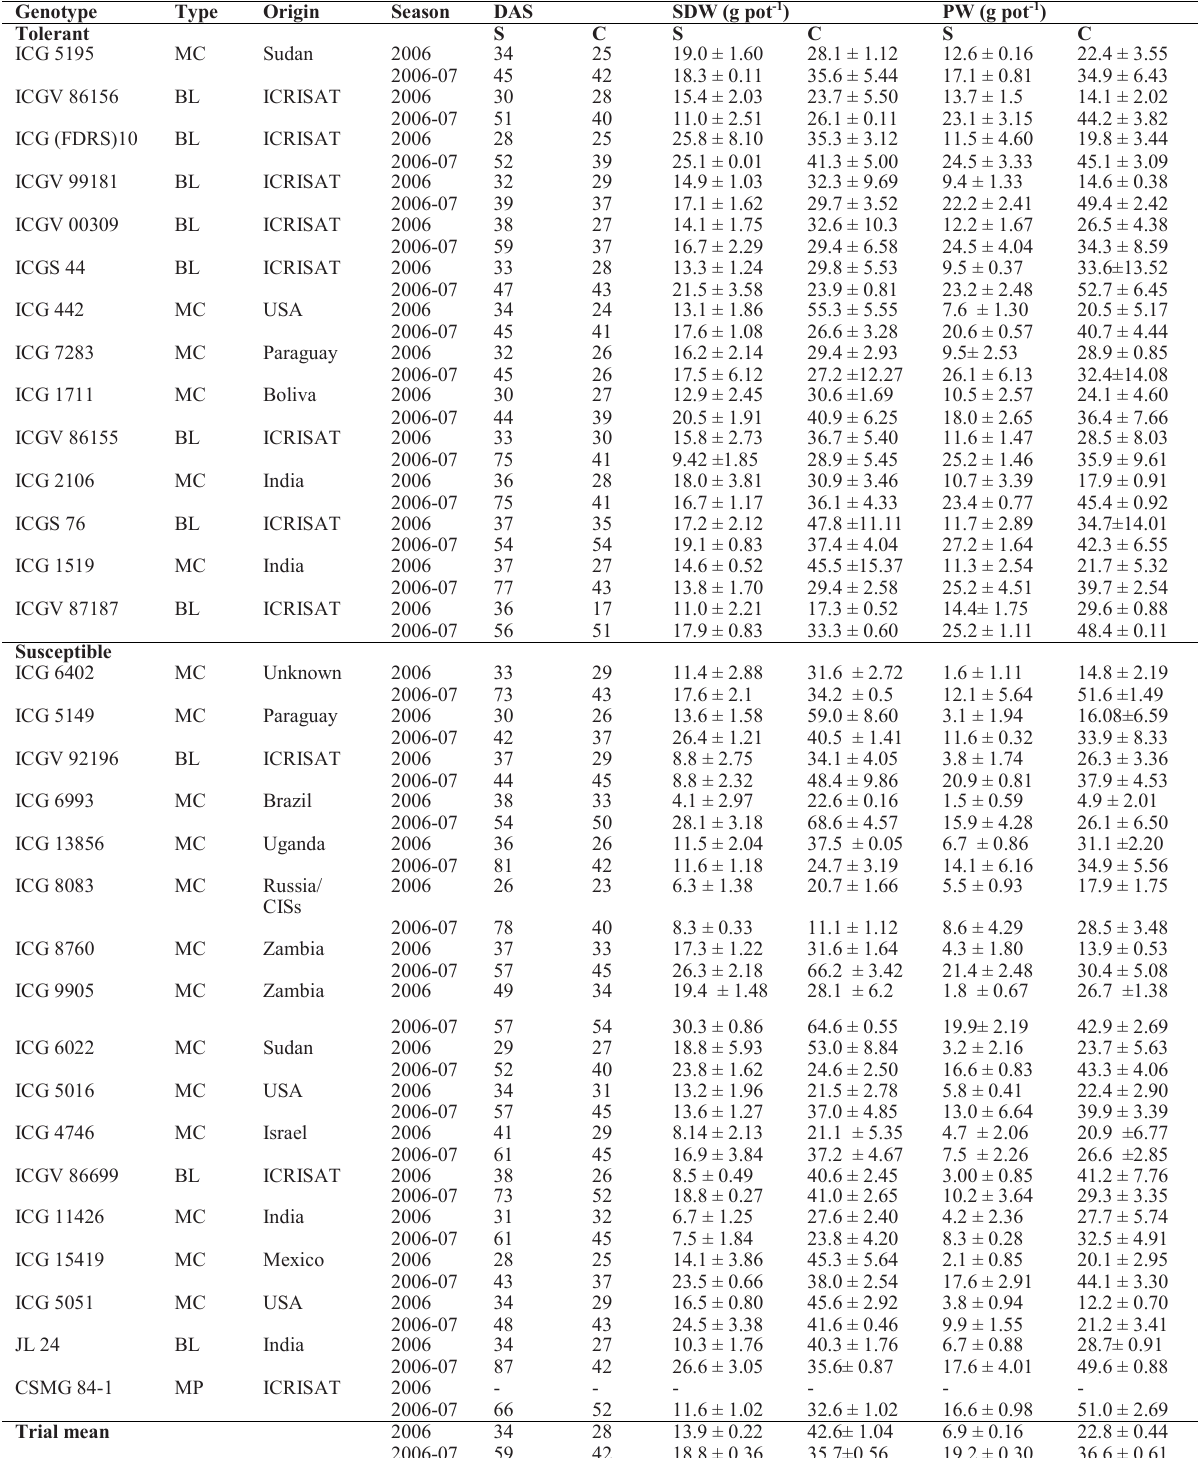
Table 5. List of 14 most tolerant and 17 most susceptible genotypes, including germplasm type (MC, mini-core, BL, breeding line) and origin, and data o days to flowering, shoot dry weight at maturity (SDW) and pod weight at maturity (PW) from two seasons evaluation under saline (S, 1.17 g NaCl kg -1 soil) and control (C, 0 g NaCl) conditions. Data are the mean (± SE) of 3 replicated pots (containing 2 plants pot -1 ); DAS= Days to flower